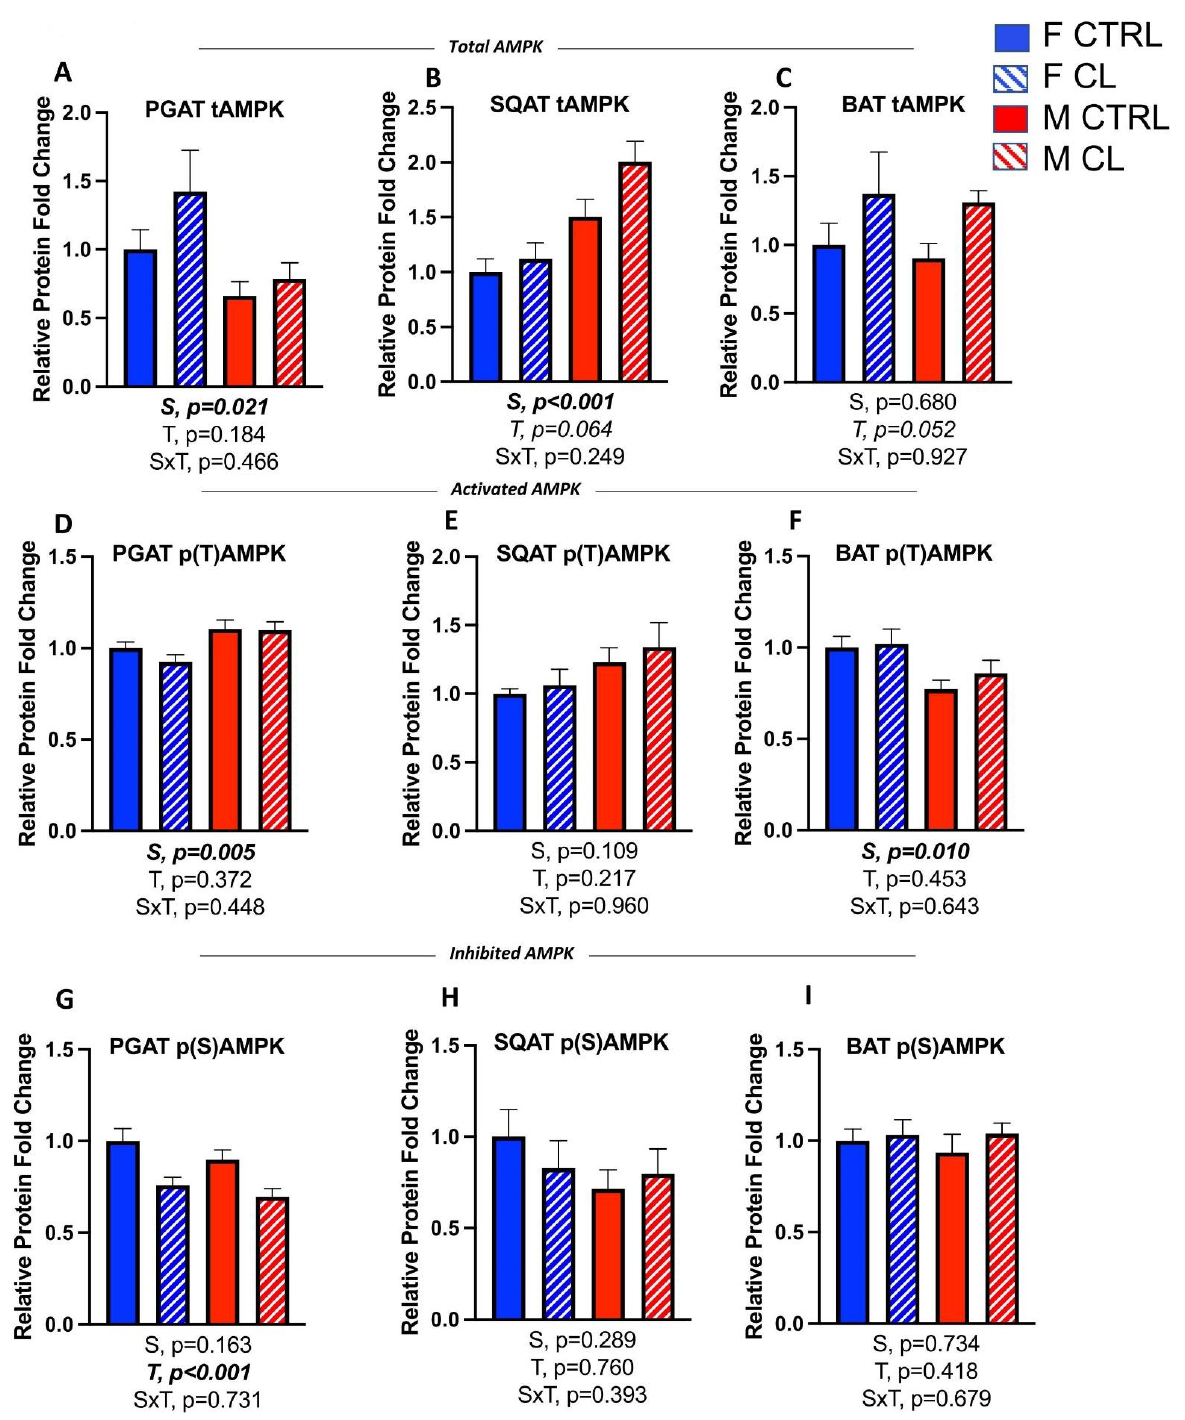
Figure 9. Male (M) and female (F) C57BL/6J mice, all on HFD, were treated for 2 weeks with daily CL injections (1 µ g/g body weight) or CTRL (saline). Perigonadal (PGAT), subcutaneous (SQAT) and brown (BAT) adipose tissue depots were collected and the relative activation (i.e., phospho-threonine (p(S)AMPK)) and inhibition (i.e., phospho-serine (p(S)AMPK)) status of AMP Kinase (AMPK) was measured relative to total AMPK (tAMPK) via Western blot. ( A ) PGAT tAMPK; ( B ) SQAT tAMPK; ( C ) BAT tAMPK; ( D ) PGAT p(T)AMPK/tAMPK; ( E ) SQAT p(T)AMPK/tAMPK; ( F ) BAT p(T)AMPK/tAMPK; ( G ) PGAT p(S)AMPK/tAMPK; ( H ) SQAT p(S)AMPK/tAMPK; ( I ) BAT p(S)AMPK/tAMPK. Representative Western blot images are provided as a Supplementary Figure. All data are presented as mean ± SEM, relative to the F CTRL. N = 7–9/group. Main effects of sex (S), CL treatment (T) and sex by treatment interactions (S × T) were determined by 2 × 2 ANOVA and are presented below the respective figures. p -values < 0.05 accepted as significant.